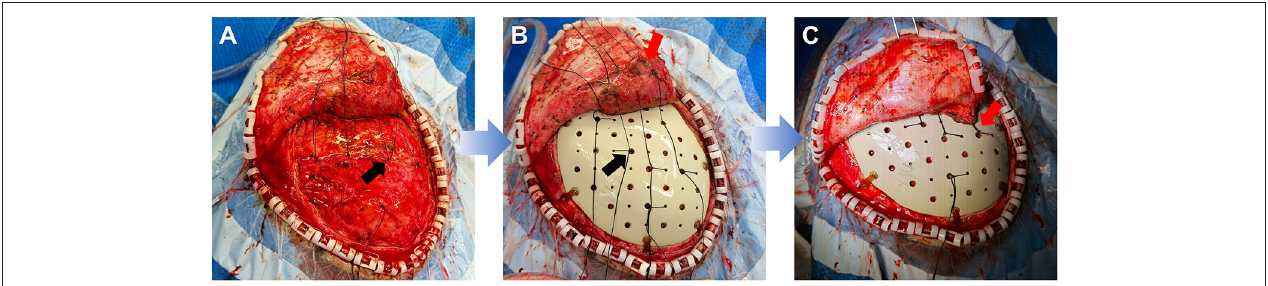
FIGURE 7 | The procedure of suspending dura and temporalis. (A) Leaving the sutures on residues of temporalis fascia on dura. Black arrow: the tie of sutures on residues of temporalis fascia. (B) Suspending the dura on the plate and suturing the rim of the temporalis. Black arrow: the tie of suspending sutures on the plate; Red arrow: the sutures on the rim of temporalis. (C) Suspending the temporalis on the plate and tightly adhering the plate together with dura. Red arrow: the tie of suspending suture of both dura and temporalis. (Consent for publication has taken from this patient).